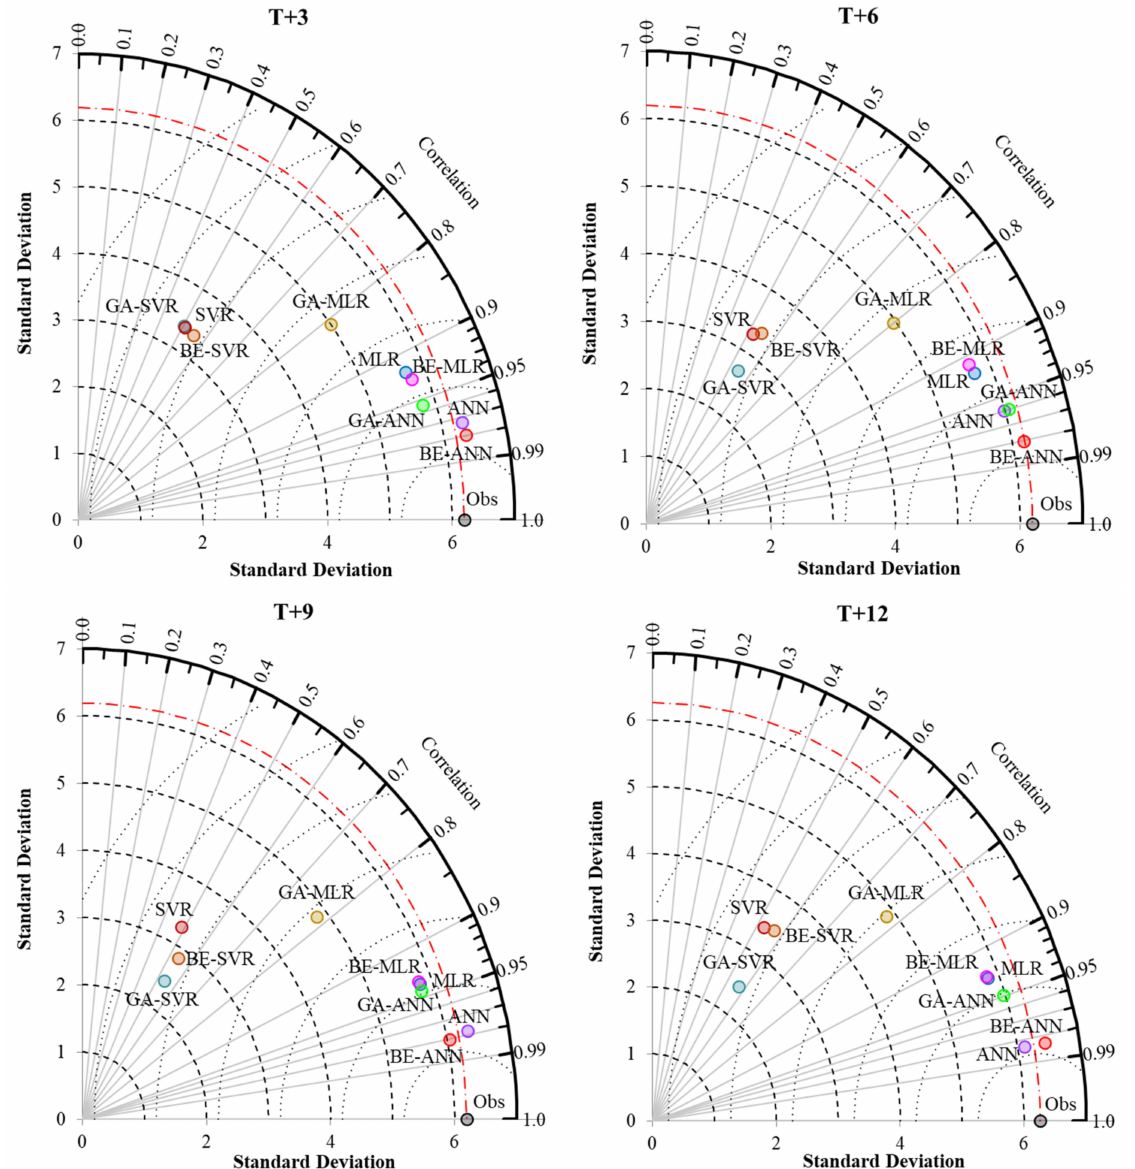
Figure 7. Tylor diagram of nine ML models for monthly reservoir inflow